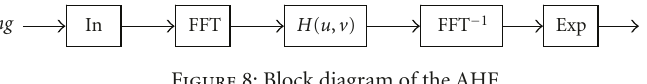
Figure 8: Block diagram of the AHF. Table 2: Results after processing with ICA.